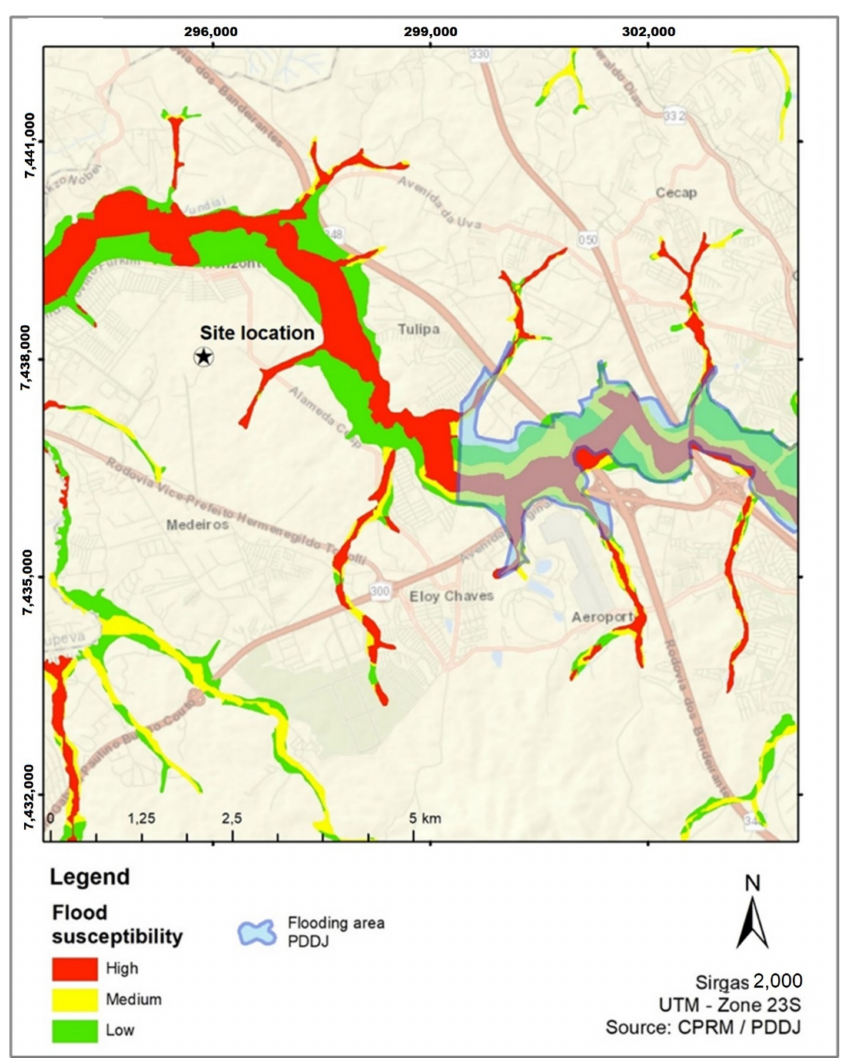
Figure 4. Consolidation of existing flooding maps in the industrial park